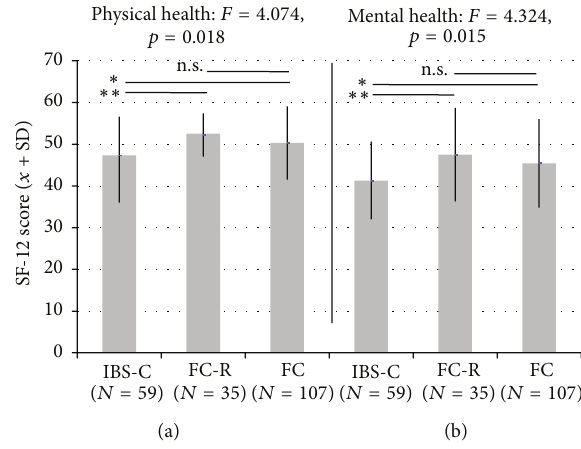
Figure 1: Quality-of-life in groups of constipated participants (individuals with IBS-C, FC-R, and FC, see text for definitions) as measured by the SF-12 (arbitrary units, mean ± SD) in the physical domain (a) and the mental domain (b). 𝐹 -values indicate signifi- cance in the between-group ANOVA. “ ∗ ” indicating significance in post hoc 𝑡 -tests (uncorrected): ∗∗∗ 𝑝 < 0.001 ; ∗∗ 𝑝 < 0.01 ; ∗ 𝑝 < 0.05